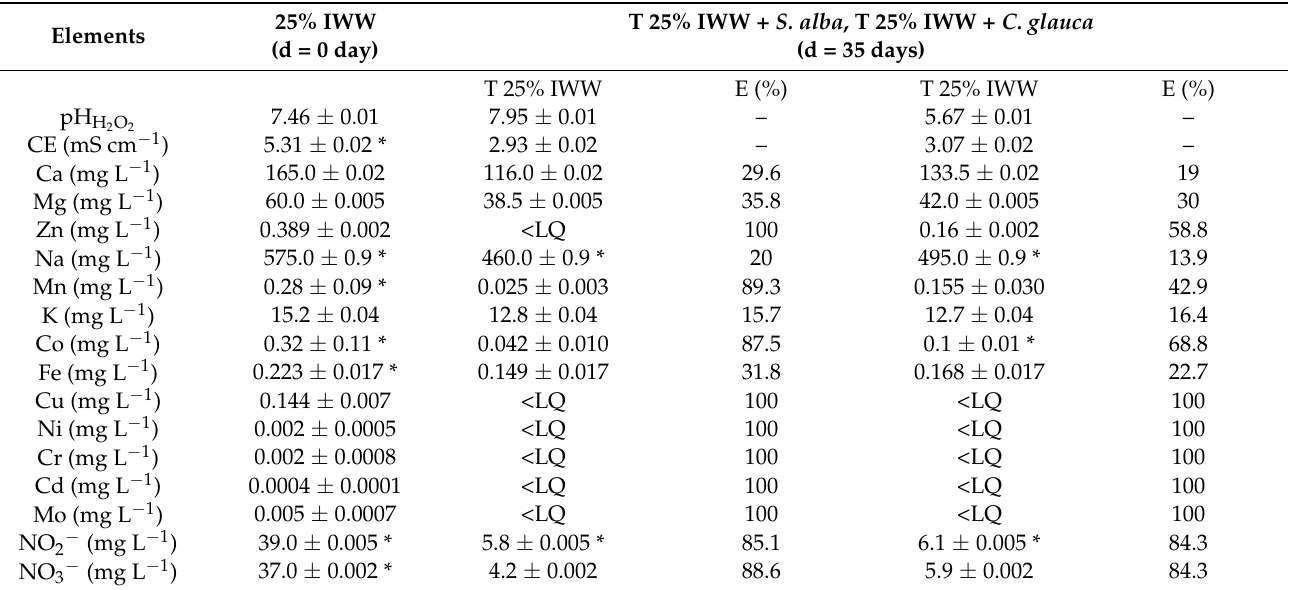
Table 4. Physicochemical parameters (mean ± SD, n = 3) of diluted untreated industrial wastewater (25% IWW) over time: d = 0 day, of the diluted treated industrial wastewater (T 25% IWW) with S. alba or C. glauca after 35 days of treatment and the efficiency of this treatment (E) for these 2 species. Three replications ± SD of each parameter were carried